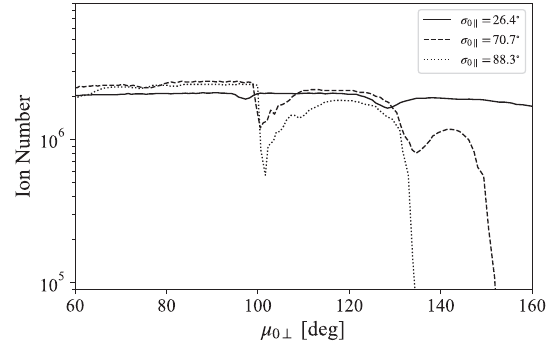
FIG. 5. Ion losses due to the transverse overfocusing effect caused by the removal of an axial potential barrier. The transverse phase advance μ 0 ⊥ is varied over a wide range with the synchrotron phase advance adjusted to σ 0 k ¼ 26 . 4 °, 70 . 7 °, and 88 . 3 °. An ion bunch is generated initially at ð μ ð 50 . 0 ° ; 26 . 4 ° Þ in all three cases. After about 2 × 10 6 ions are accumulated there, the operating point is quickly moved onto a fixed- σ 0 k line and stay there for 150 μ s before ion extraction.